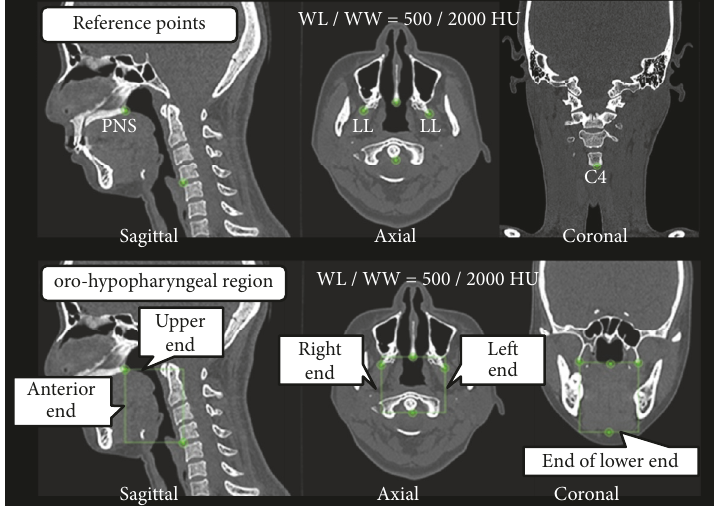
Figure 4: The oro-hypopharyngeal region on the multiplanar reconstruction (MPR) image. Abbreviation: WL/WW, window level/window